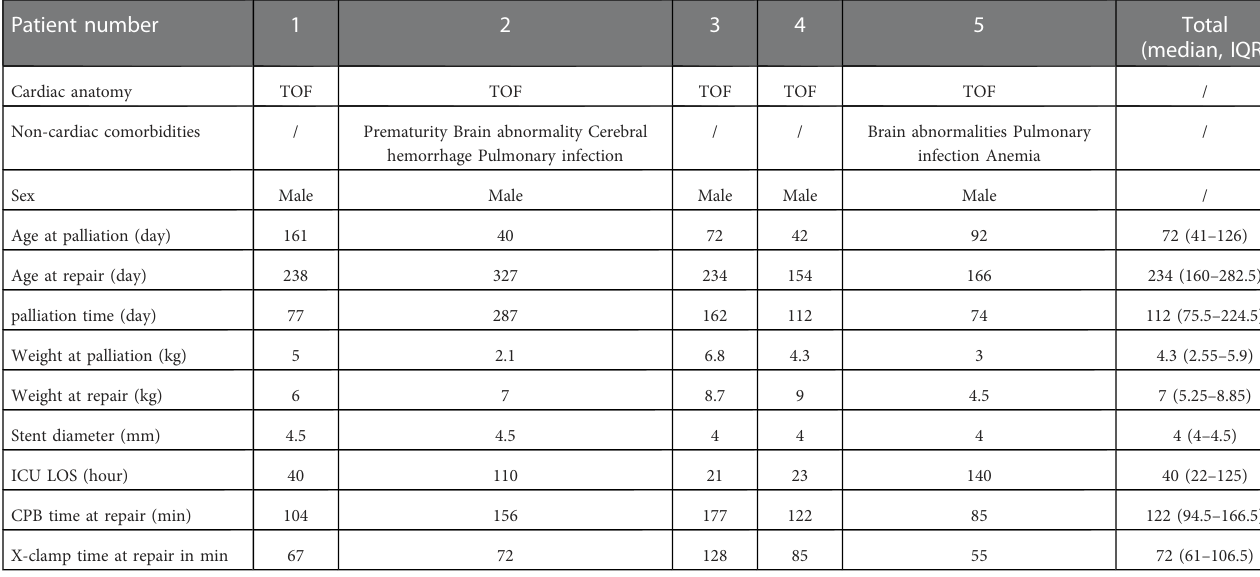
TABLE 1 RVOT stenting patient features at palliation and repair